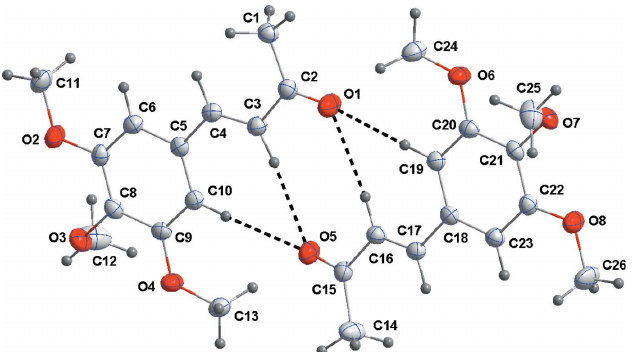
Figure 1 The asymmetric unit showing 50% probability ellipsoids. C—H (cid:2)(cid:2)(cid:2) O hydrogen bonds are shown by dashed lines